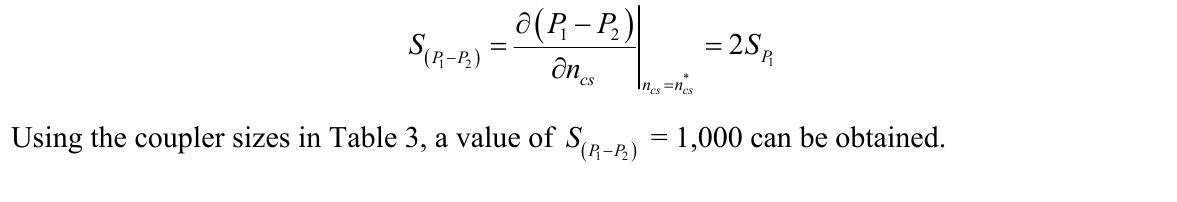
Figure 14 . Level curves of